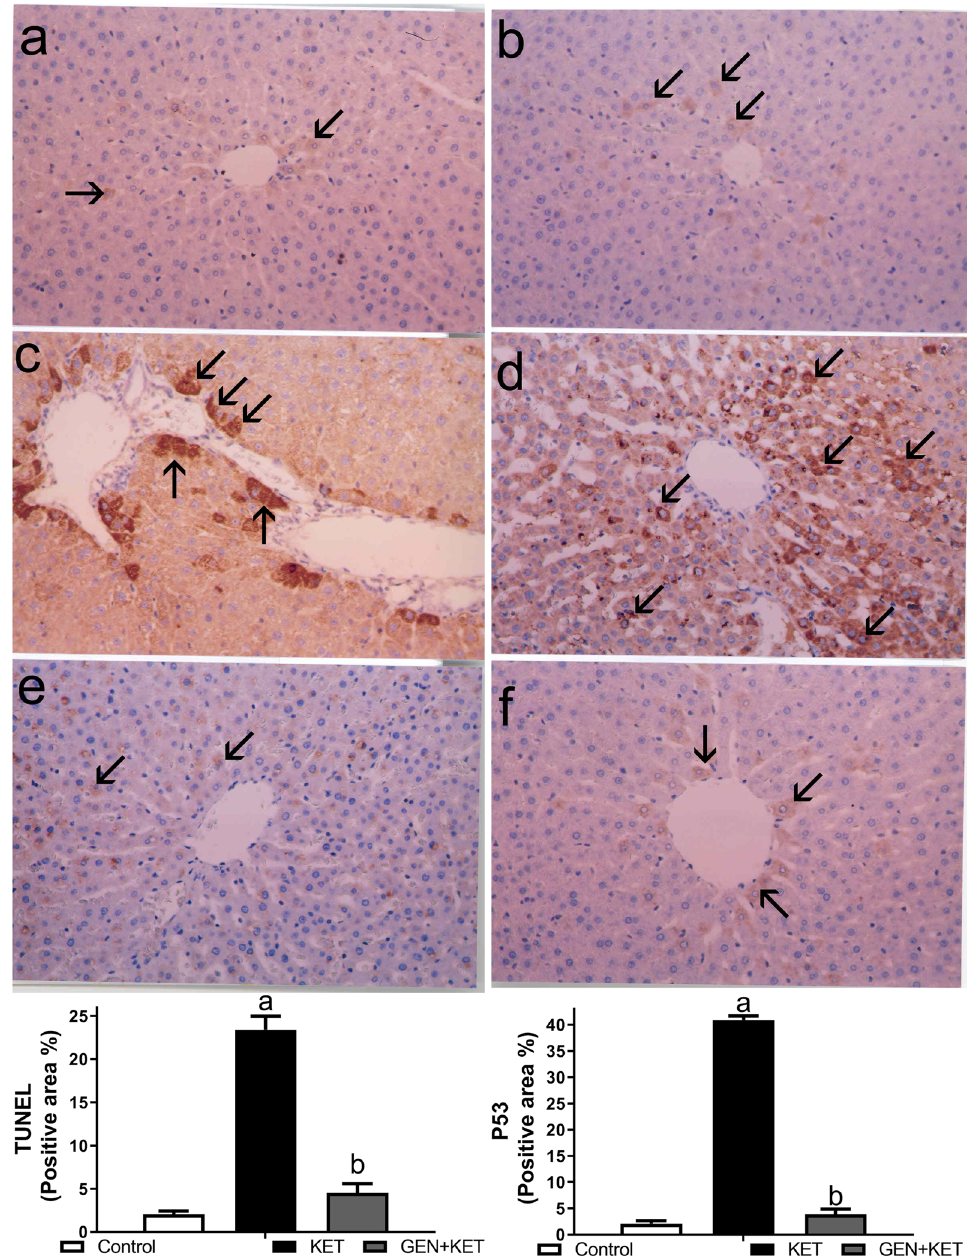
Fig. 5 Photomicrographs of liver sections showing the effect of GEN on KET-induced DNA strand breaks (TUNEL assay) and increased in P53 protein expression. In liver section of control rats some cells are positive for TUNEL staining ( a ) and P53 immunoreactivity ( b ), the hepatocyte nuclei and cytosol stained brown (arrows). Liver sections of KET-treated rats showing extensive TUNEL-positive cells ( c ), and P53-positive cells ( d ), (arrows). Group of rats treated with GEN KET had nearly normal appearance of hepatocytes with a marked reduction in TUNEL-positive cells ( e ) + and P53-positive cells ( f ). Sections were counterstained with hematoxylin (X 200). Columns represent number of TUNEL- and P53-positive cells as a percentage of total area (5 scope field count for five animals in each group), and values are expressed as mean SEM. Significance was determined ± by one-way analysis of variance followed by Dennett’s t test:. a and b indicate significant differences relative to control and KET groups,